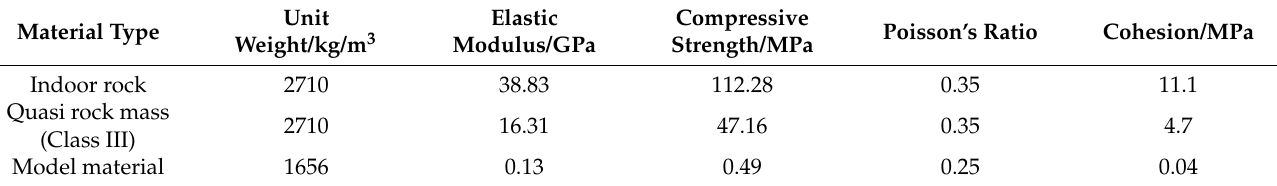
Table 1. The physical and mechanical parameters of the physical model materials.